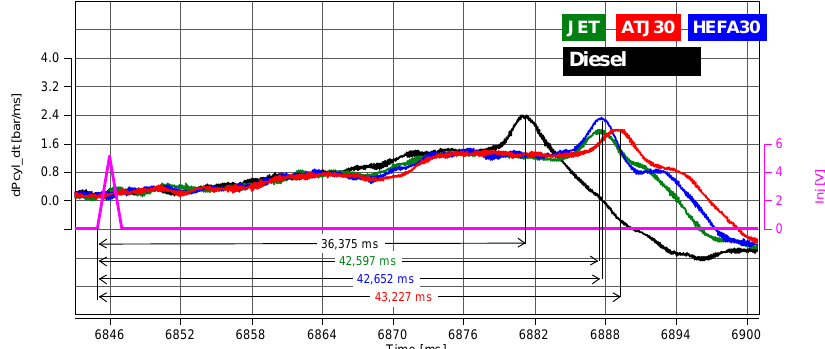
Figure 11. Obtained values of the autoignition delay of the investigated fuels.